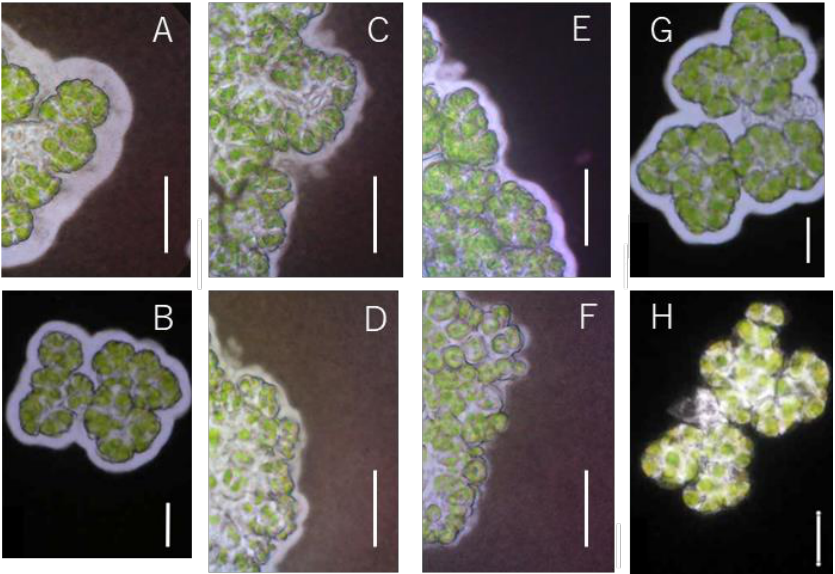
Figure 2. Optical microscope image of algal slurry of Yamanaka strain mixed with India ink. White bars in the lower right corner of the image indicate 20 µm. ( A , B ), Chu13; ( C ), 0.4% SM at day 4; ( D ), 0.4% SM at day 20; ( E ), 0.6% SM at day 4; ( F ), 0.6% SM at day 20; ( G ), heat treatment at 55 °C; ( H ), heat treatment at 60 °C.